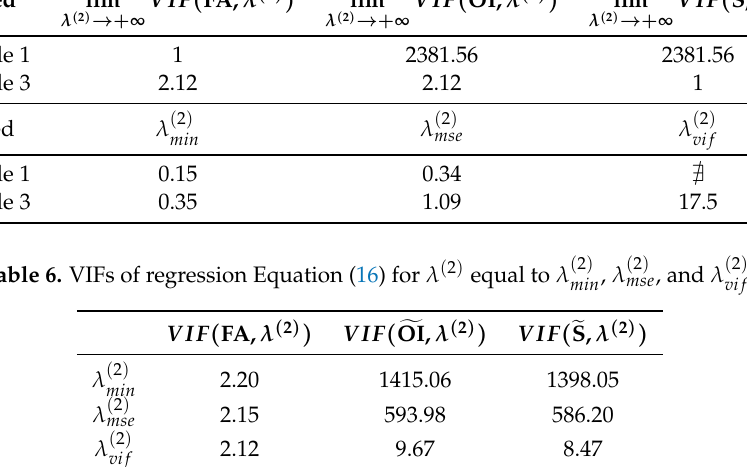
Table 6. VIFs of regression Equation (16) for λ ( 2 ) equal to λ